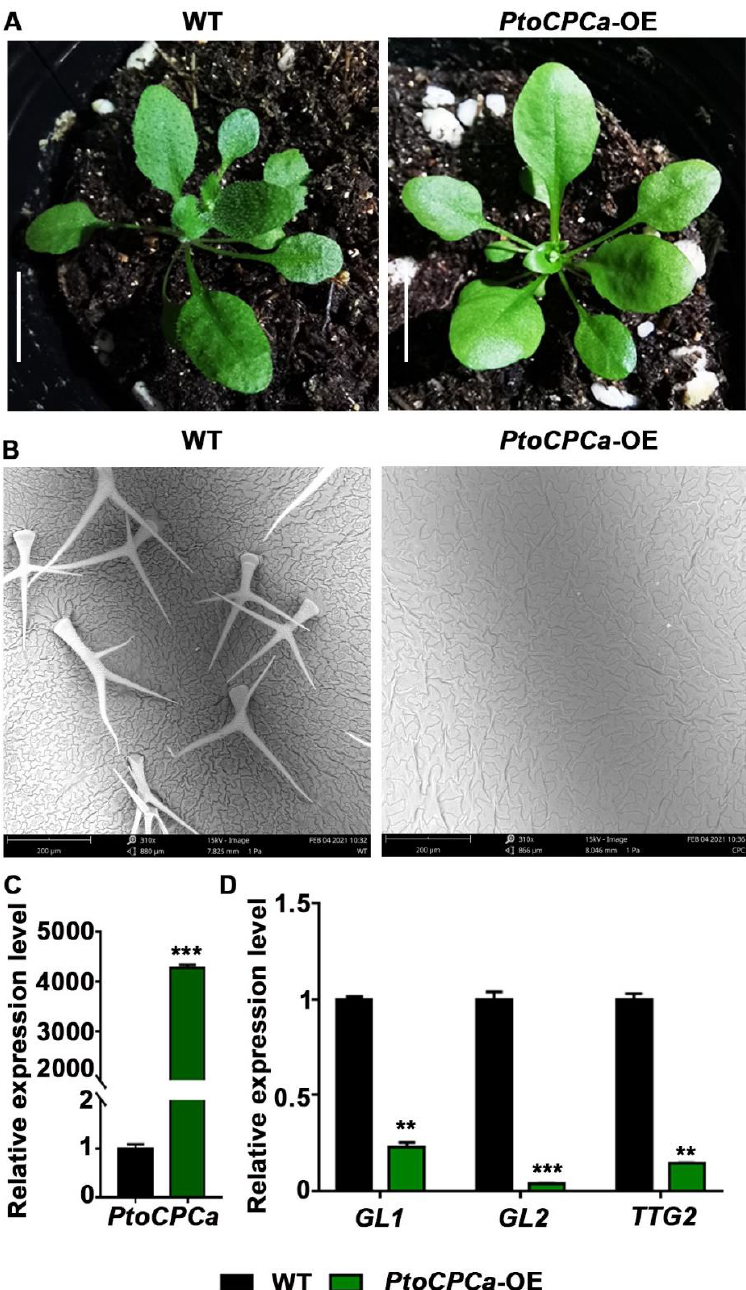
Figure 4. PtoCPCa overexpression inhibits trichome development in A thaliana . ( A ) Morphological phenotypes of 3-week-old WT and PtoCPCa -OE lines. ( B ) Scanning electron microscopy (SEM) of trichomes of 3-week-old WT and PtoCPCa -OE lines. ( C ) Expression levels of PtoCPCa in WT and PtoCPCa -OE lines. ( D ) Expression levels of trichome development marker genes in WT and PtoCPCa -OE lines, including GL1 (AT3G27920), GL2 (AT1G79840), and TTG2 (AT2G37260). Actin7 was used as an internal control. Error bars represent the standard error (S.E.) of three independent biological replicates. Asterisks indicate a significant difference with respect to WT plants using the Student’s t -test (**, p < 0.01; ***, p < 0.001). Scale bars: ( A ) 1 cm; ( B ) 200 μm.